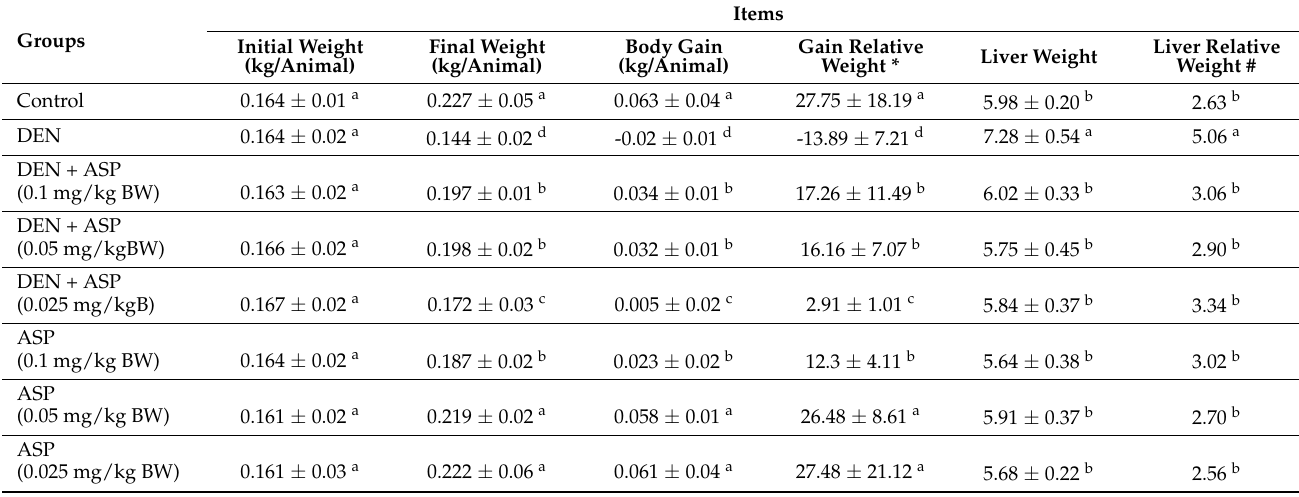
Table 3. Body weight, liver weight and relative weight changes of control, DEN and Aspergillus awameri supplemented rat groups.